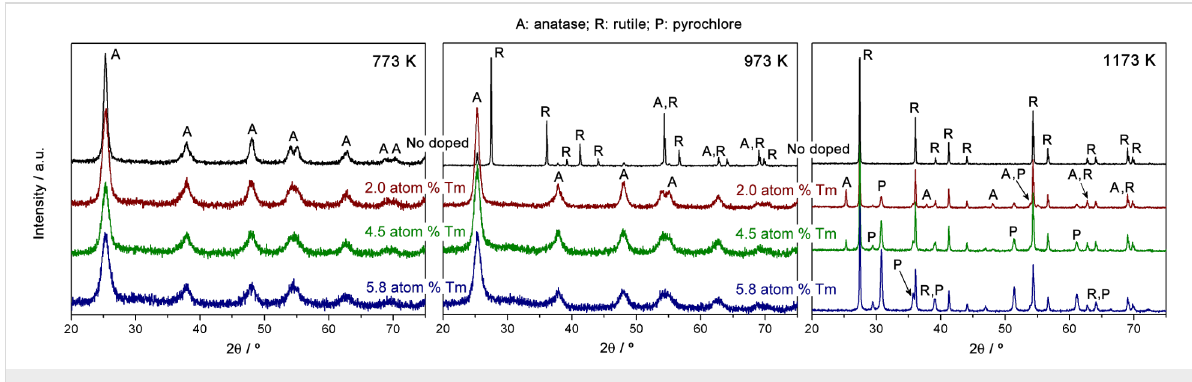
Figure 1: XRD patterns of the samples synthesized.